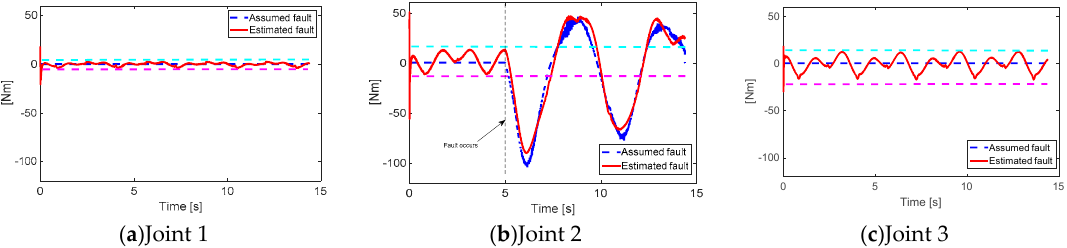
Figure 8. Fault estimation results with a single joint fault occurs at Joint 2. The aqua and pink dashed lines are the upper and lower thresholds, respectively.